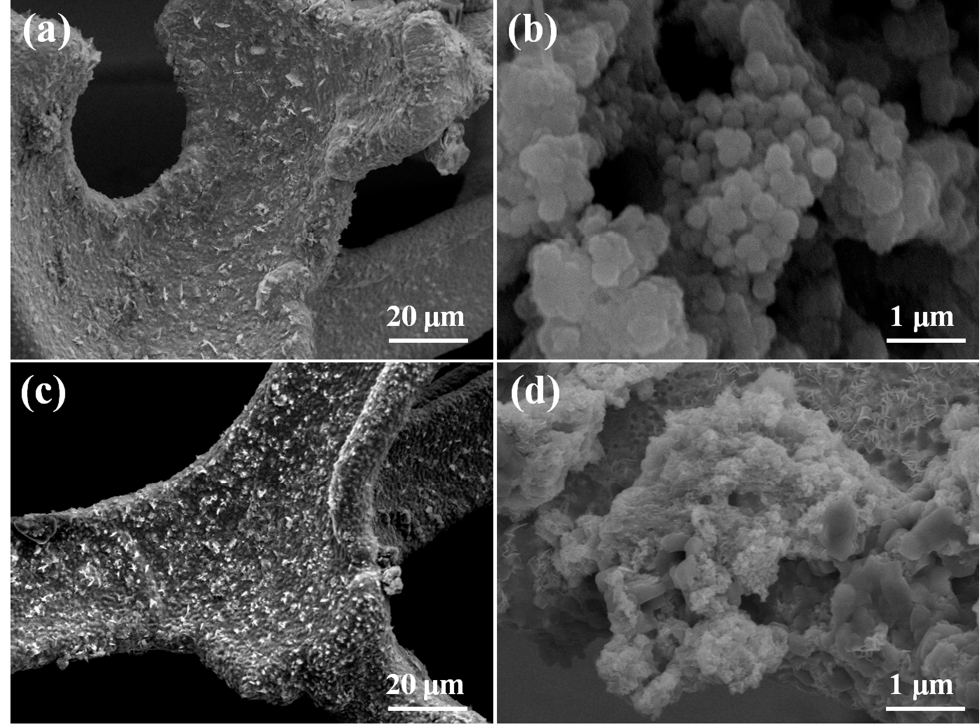
Figure 2. ( a,b ) SEM and FESEM images of pure NiCo 2 S 4 nanoparticles electrode; and ( c,d ) SEM and FESEM images of the sulfur-deficient NiCo 2 S 4 nanosheets composite. Figure 3 displayed the TEM and HRTEM images of sulfur-deficient NiCo 2 S 4